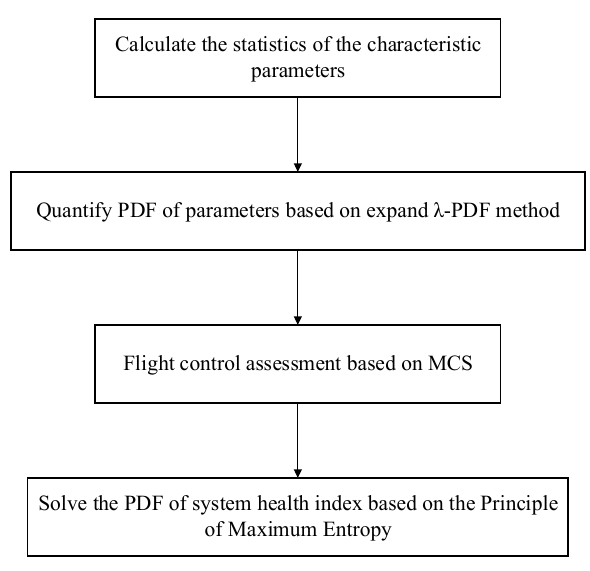
Figure 3. Flight control system health assessment process under uncertain conditions.